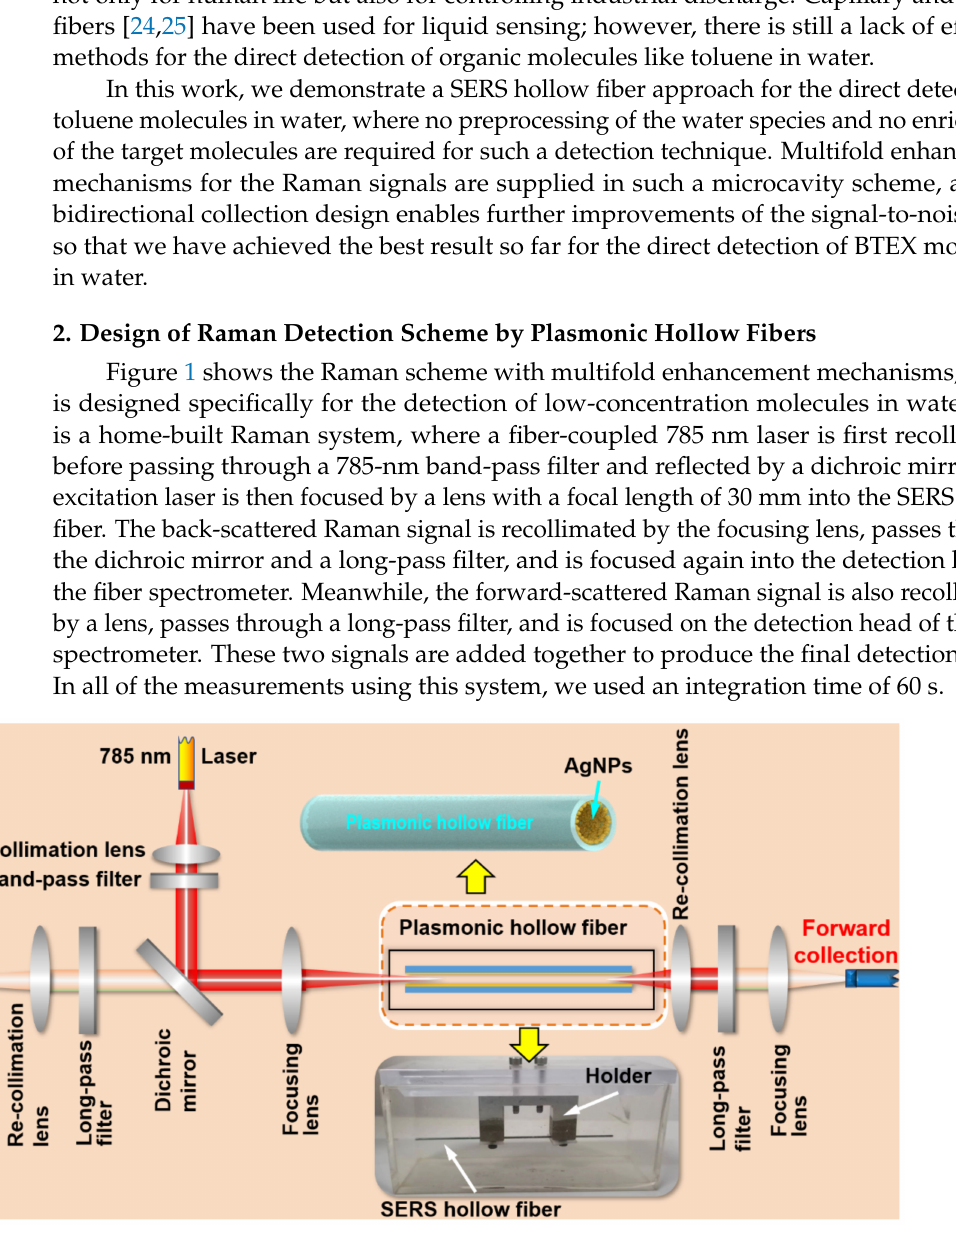
Figure 1. Design of the multifold enhanced Raman detection